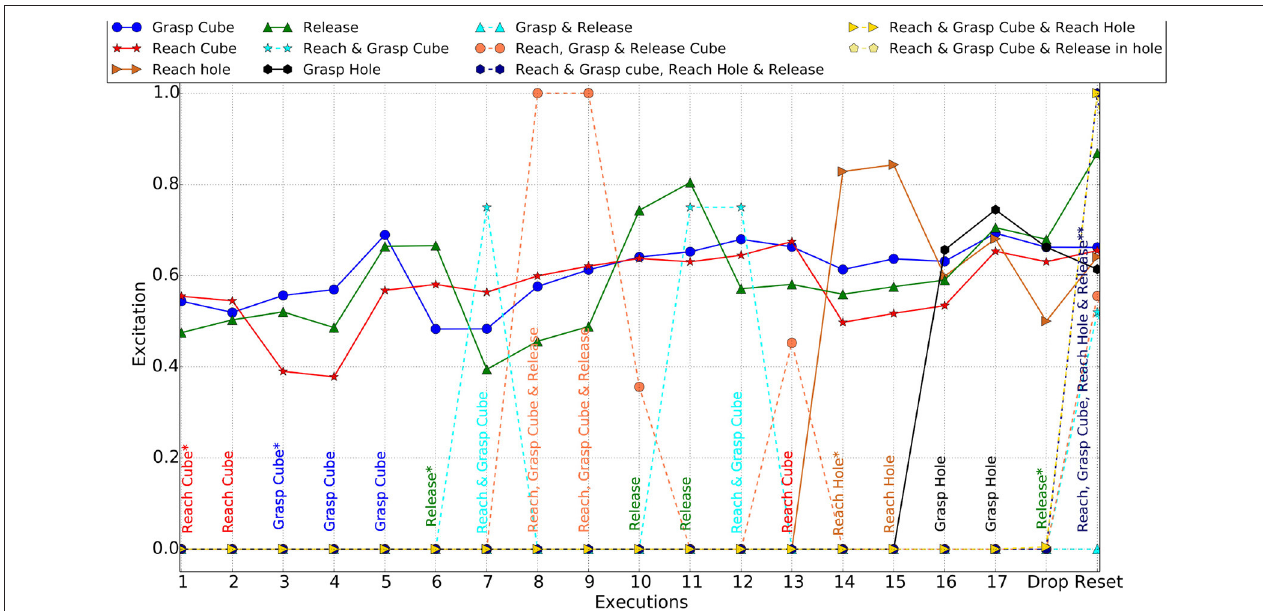
FIGURE 12 | Schema and Chain excitations (Simulator). The most excited schema/chain at each execution is specified across the bottom. Actions with asterisk(*) are the positions at which new schemas emerged and with asterisk(**) are the positions where generalized schema created. The chains contain emerged schemas only. Each solid lines shows excitation of the corresponding schema, whereas dashed line shows that of a